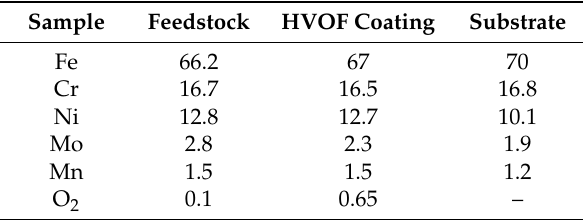
Table 4. Average chemical composition of the AISI 316L samples in different conditions, measured